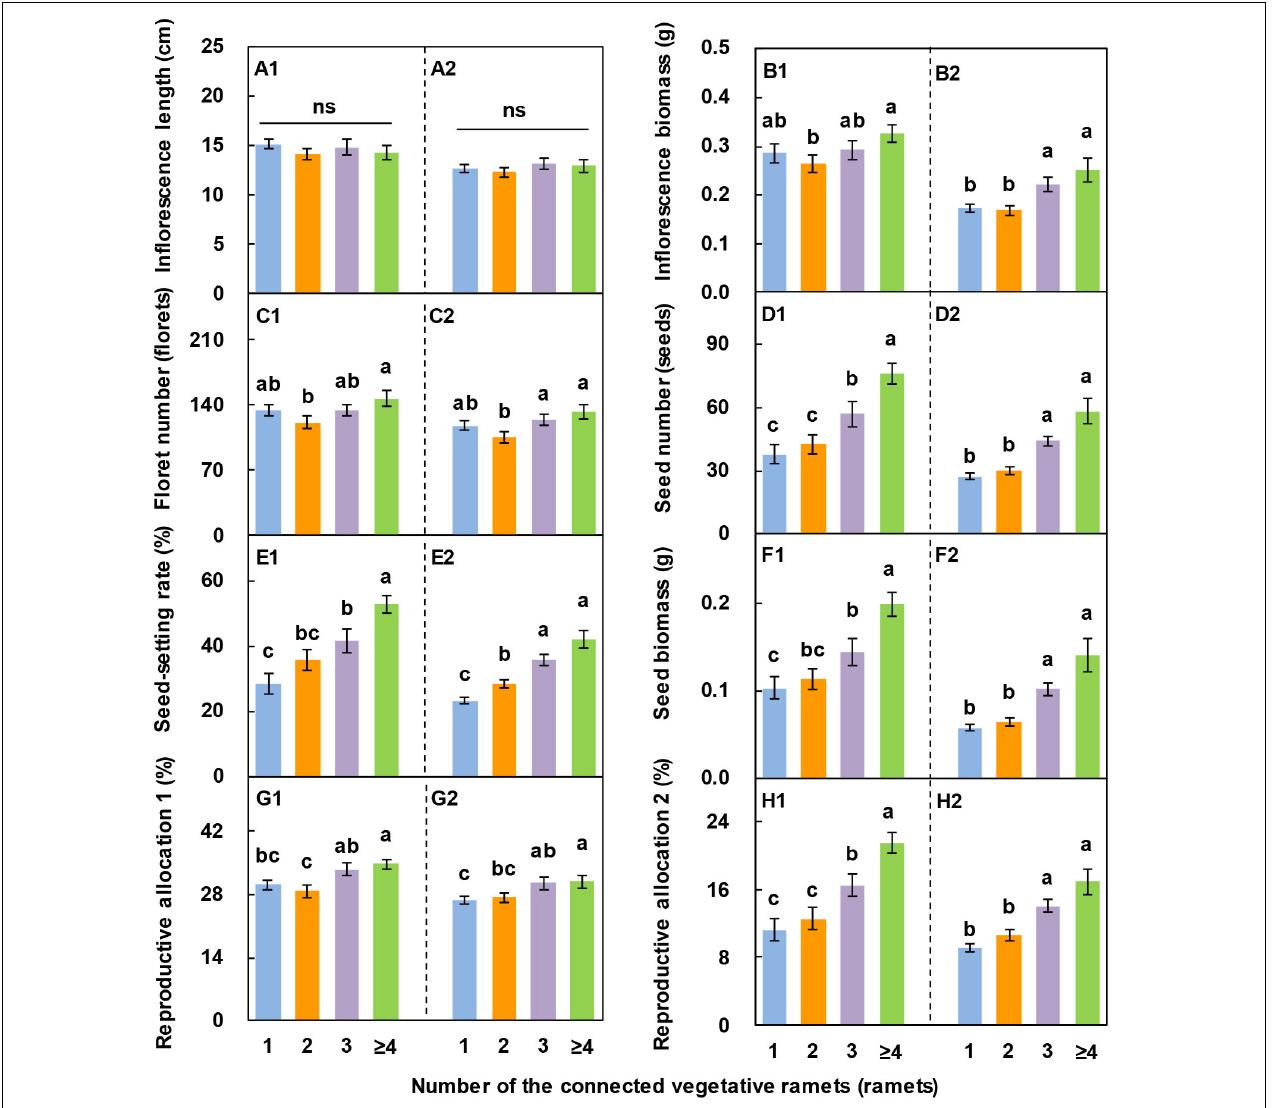
FIGURE 5 | Effects of the number of vegetative ramets connected to tillering nodes on sexual reproductive characteristics in Leymus chinensis populations over two consecutive years (2017, A1–H1 ; 2018, A2–H2 ). Data are the means ± SE ( n = 25). Different lowercase letters indicate significant differences ( P < 0.05) between different numbers of vegetative ramets, and ns indicates that there is no significant difference ( P > 0.05) between different numbers of vegetative